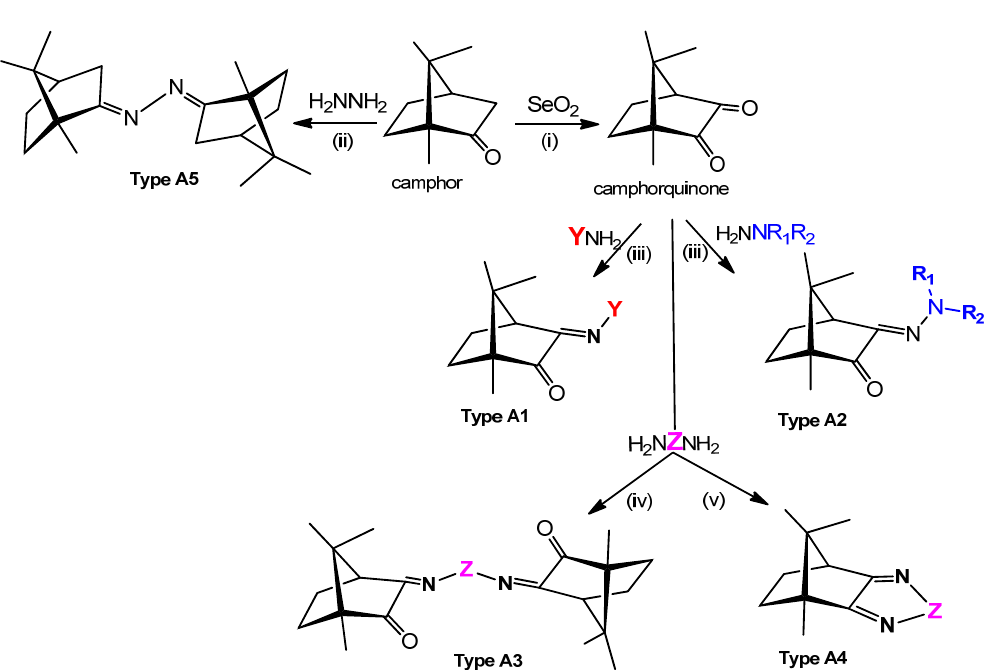
Figure 4. Camphor derivatives of the imine type: Y-aromatic or aliphatic; R 1 = H, Me, Ph; R 2 = H, Me, Ph, among others; Z = phenyl; biphenyl, linear alkane. For preparative details see references (i)—[48];